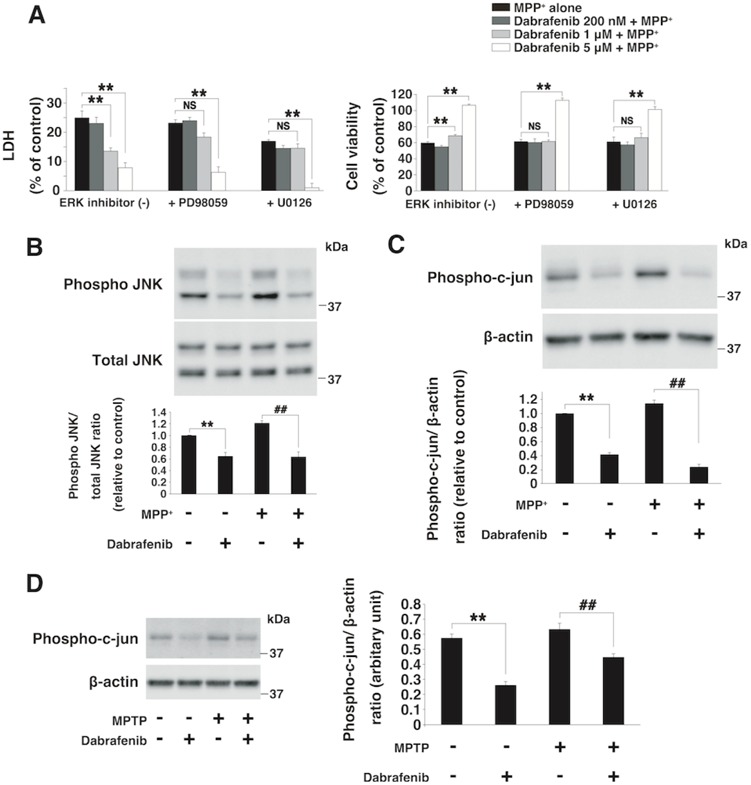
Dabrafenib reduced the expression of phosphorylated JNK and c-jun in both SH-SY5Y cells and mice(A) LDH/cell viability assay under the condition of ERK inhibitor. Neuroprotective effects of dabrafenib (5 μM) were not dependent on the downregulation of activated ERK expression by PD98059 (30 μM) or U0126 (3 μM). Neuroprotective effects were assessed by the LDH and cell viability assay in SH-SY5Y cells at 24 h after MPP+ (3 mM) exposure. **, P-value < 0.01 compared with the MPP+ alone group; NS, not significant (n = 3 per group). (B) Immunoblot of phosphorylated JNK in SH-SY5Y cells at 30 min after drug treatment. Dabrafenib (5 μM) inhibited the phosphorylation of JNK with or without MPP+ (3 mM). **, P-value < 0.01 compared with control; ##, P-value < 0.01 compared with MPP+ alone (n = 3 per group). (C) Immunoblot for phospho-c-jun in SH-SY5Y cells at 24 h after drug treatment. Dabrafenib (5 μM) decreased the expression of phospho-c-jun with or without MPP+ 3 mM. **, P-value < 0.01 compared with control; ##, P-value < 0.01 compared with MPP+ alone (n = 3 per group). (D) Protein expression of phospho-c-jun in the substantia nigra of mice at 1 week after MPTP-injection. Dabrafenib significantly decreased the expression of phospho-c-jun with or without MPTP. **, P-value < 0.01 compared with the normal control group; ##, P-value < 0.01 compared with the vehicle + MPTP group (n = 4–5 per group). Data represent the mean ± s.e.m. All statistical analyses in this figure were performed using one-way ANOVA with the Tukey post-hoc test.